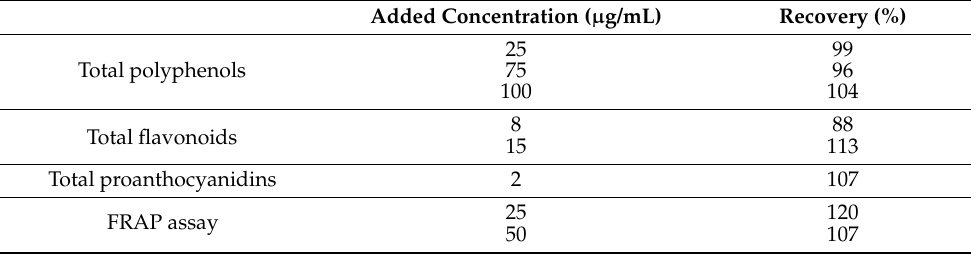
Table 3. Antioxidant recovery determinations by spectrophotometry. Added Concentration ( µ